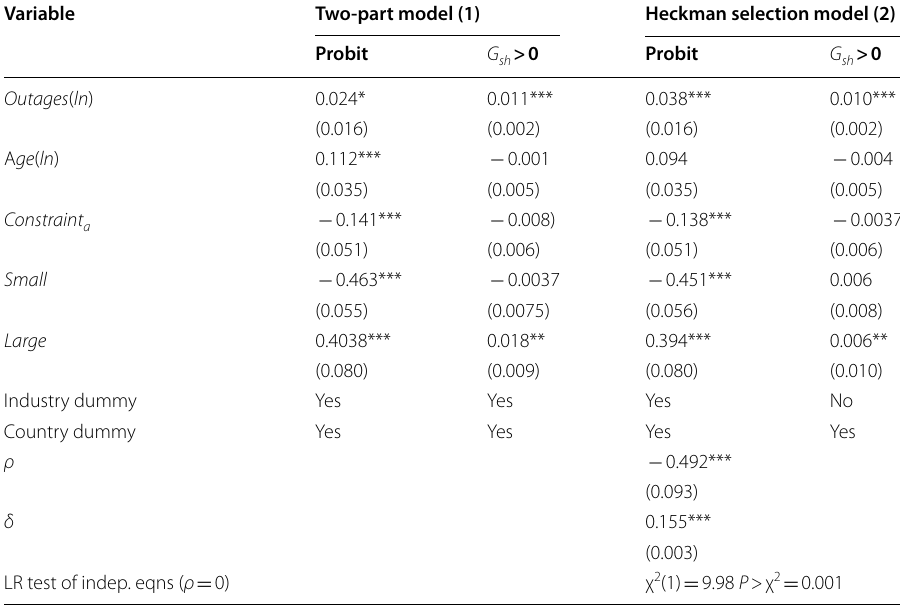
Table 4 Credit constraint and Investment in